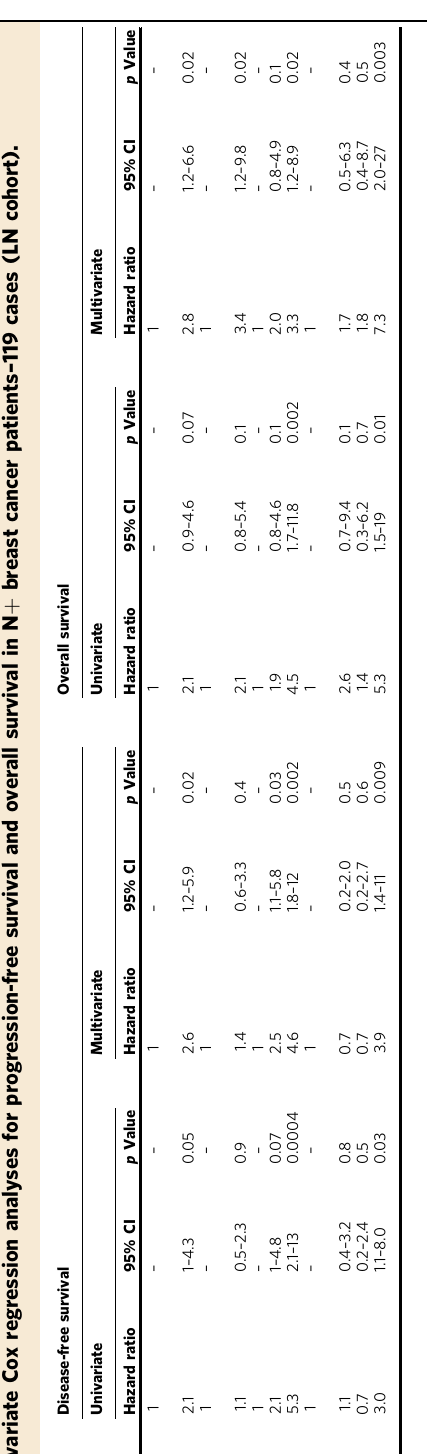
areas in representative invaded LNs were further analyzed. Images were aligned using elastic transformation from Fiji software plugin (bUnwarpJ). This plugin uses landmarks manually de fi ned on hematoxylin & eosin staining of the sections to compute the optimal correlation between images and alignment at cellular level. Images were divided into tiles of 225 µm 2 to mimic the approximate size of one fi broblast and each tile was annotated according to the position in the section. Aligned and annotated images of the CAF markers were then submitted to color deconvolution and the intensity of each DAB staining was measured by densito- metry analysis using ImageJ software. Each tile was classi fi ed into a speci fi c CAF subset using the algorithm developed by the team (see ‘ Design of a decision tree for CAF subset prediction' and Fig. 2d), which takes as input DAB intensities of CAF markers measured within each tile. Epithelial tumor cells were detected based on EPCAM staining to better visualize the stromal compartment and each tile was colored according to the classi fi cation into CAF-S1 to CAF-S4, with CAF-S1 red, CAF-S2 orange, CAF-S3 green and CAF-S4 blue.